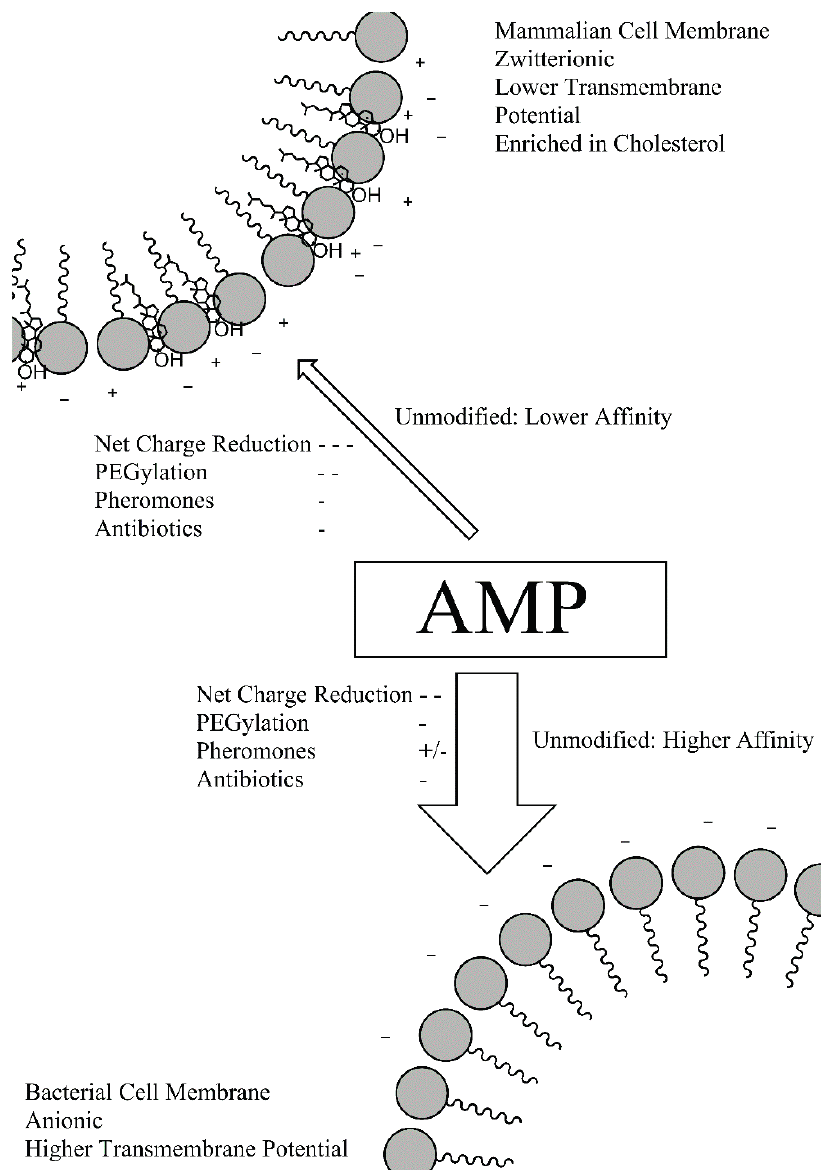
Figure 4. Overview of the effects of the different pro-moieties on the affinity of AMPs for mammalian and bacterial cell